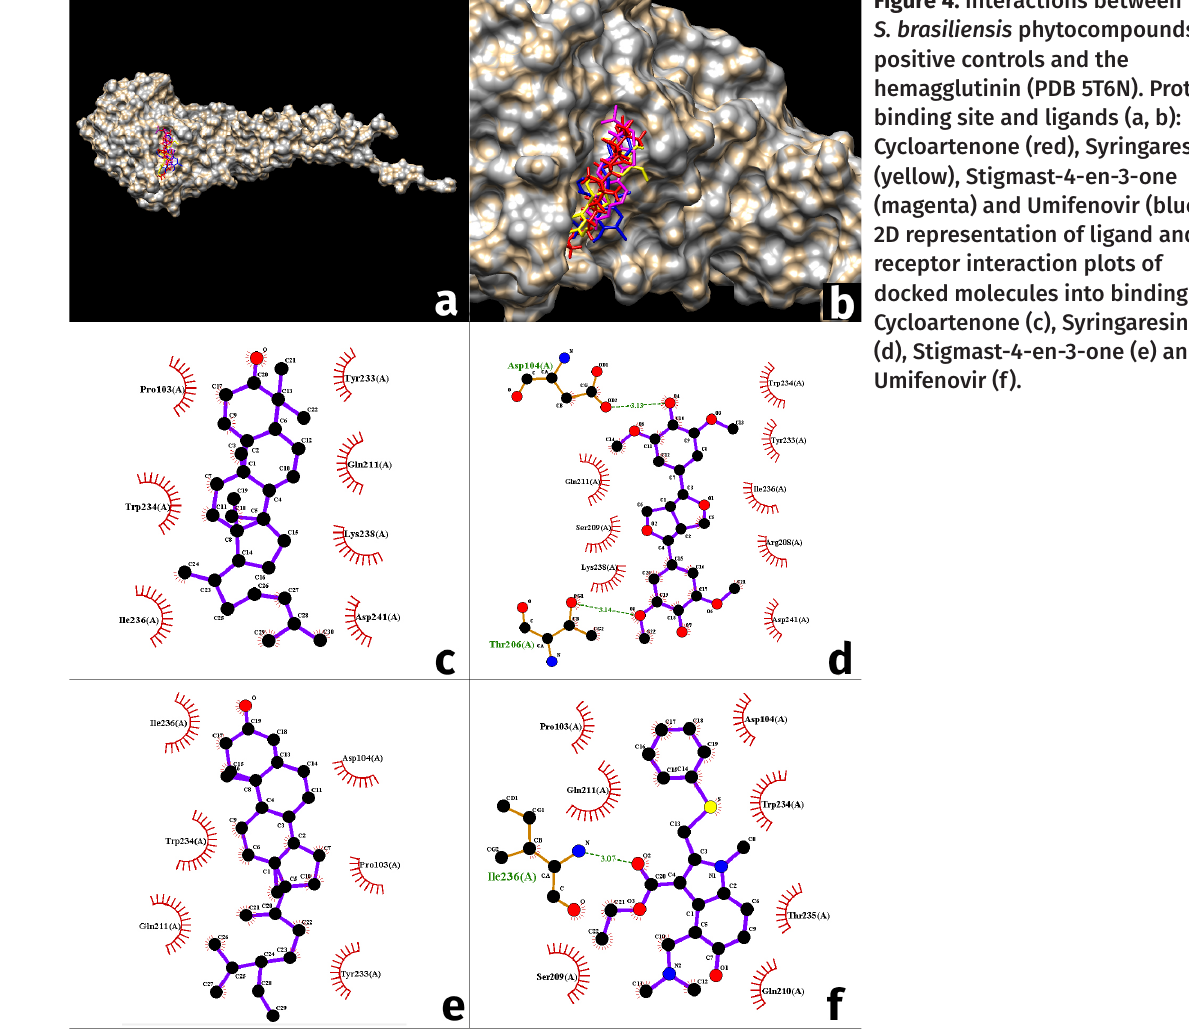
Figure 4. Interactions between the S. brasiliensis phytocompounds, positive controls and the hemagglutinin (PDB 5T6N). Protein binding site and ligands (a, b): Cycloartenone (red), Syringaresinol (yellow), Stigmast-4-en-3-one (magenta) and Umifenovir (blue), 2D representation of ligand and receptor interaction plots of docked molecules into binding site: Cycloartenone (c), Syringaresinol (d), Stigmast-4-en-3-one (e) and Umifenovir